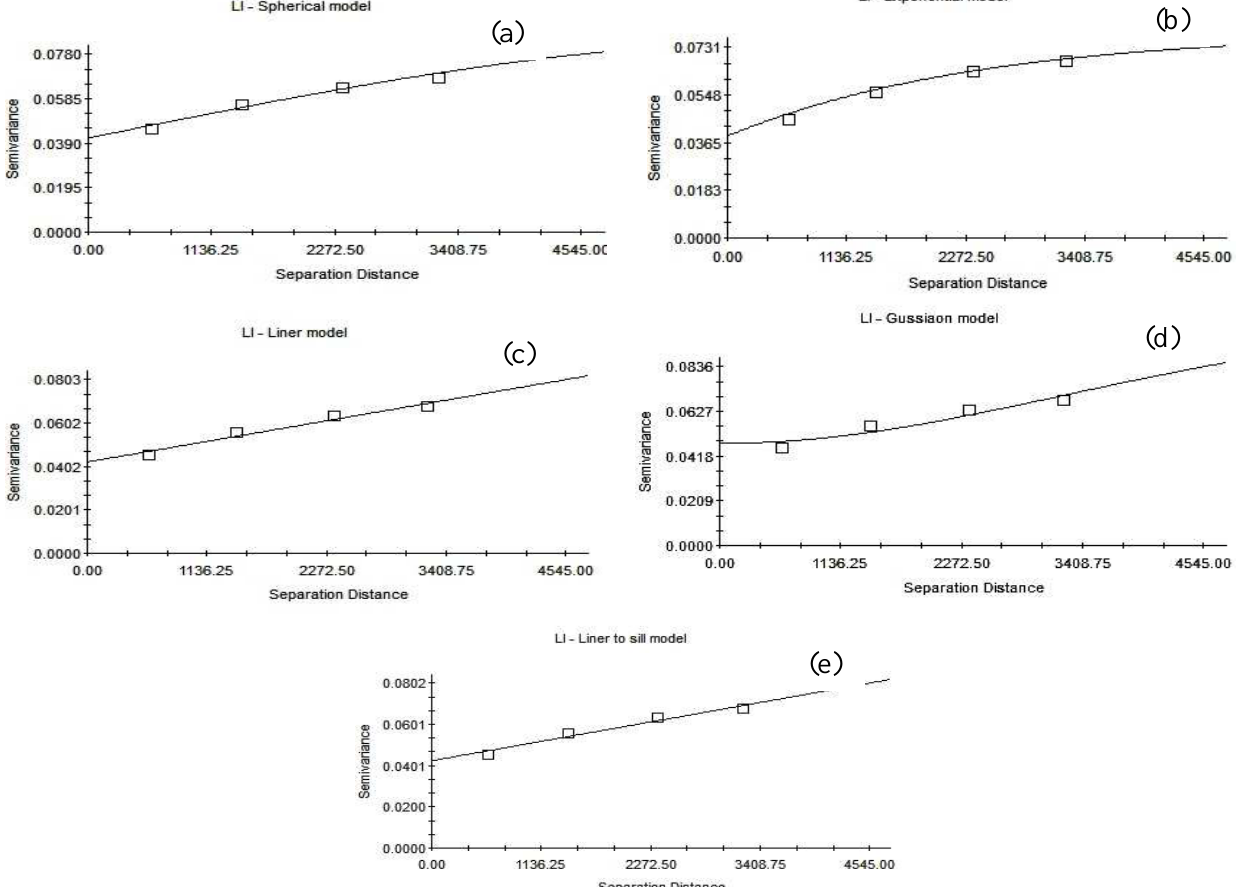
Figure 3. Fitted variogram models of Langelier saturation index (a) spherical, (b) exponential, (c) linear, (d) Gaussian, (e) linear to